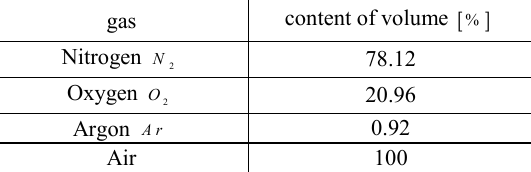
Table 2. Composition of clean dry air